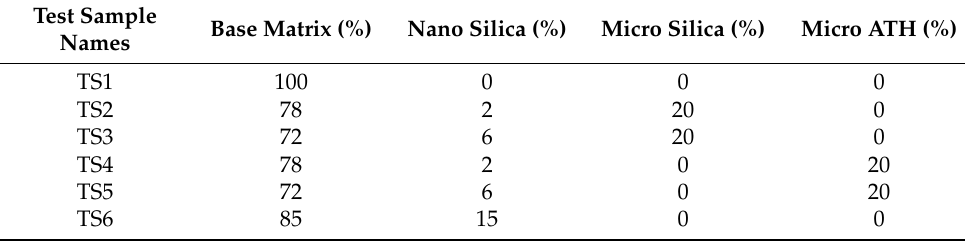
Table 1. Fabricated samples with different